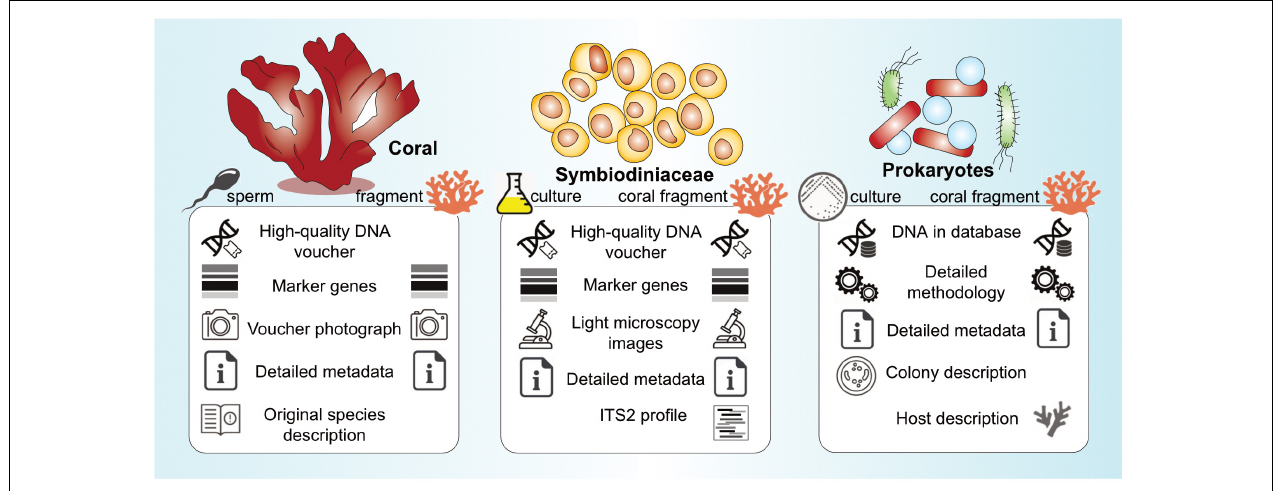
FIGURE 1 | Overview of consensus guidelines regarding metadata deposition for coral, Symbiodiniaceae, and prokaryotic specimen collections targeted for (meta)genomic sequencing (further details in Tables 1–3